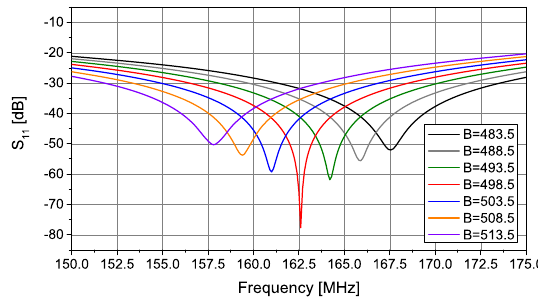
FIG. 34. Thechangeofthesimulated S 11 parameterwithlength B .